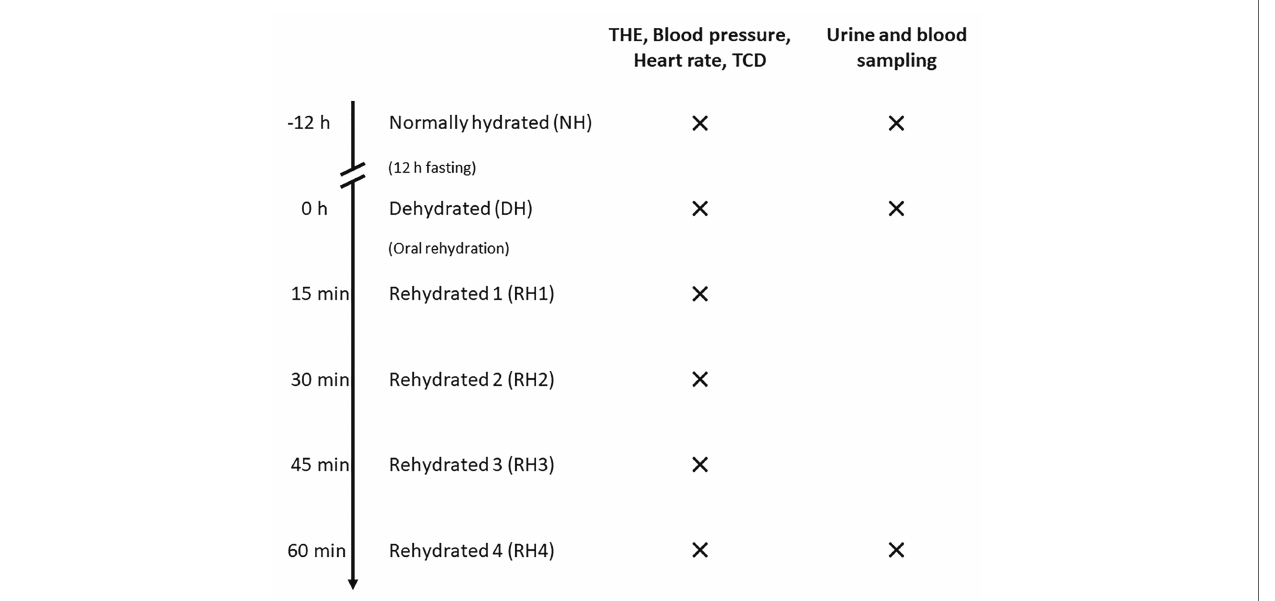
FIGURE 1 | Time sequence of THE examinations in volunteers. Volunteers were first examined in a normally hydrated state (NH). After a 12-h-fasting period, measurements were conducted in the dehydrated state (DH). Then, four sets of data in different hydration states were acquired after oral rehydration (RH1–RH4) at 15-min intervals. For every hydration state, time-harmonic elastography (THE), transcranial Doppler (TCD), and blood pressure and heart rate measurements were performed. Urine and blood for determination of urine osmolality and hematocrit were sampled at hydration states NH, DH, and RH4.